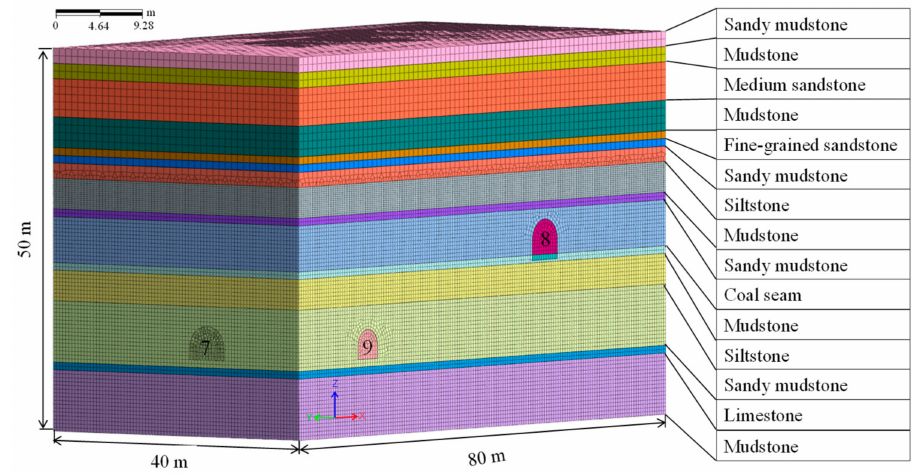
Figure 4. Actual engineering geological physical